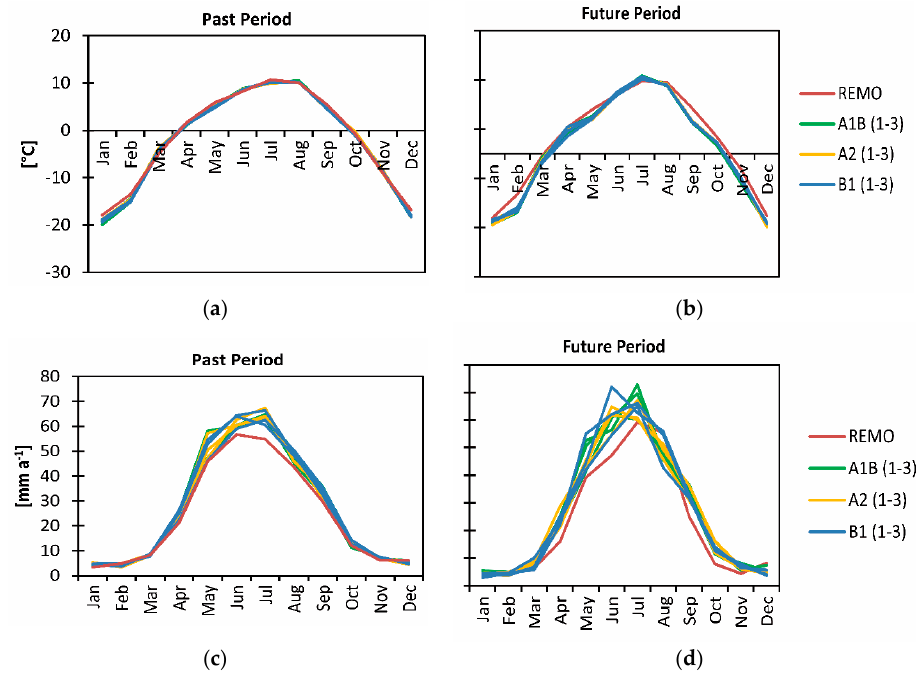
Figure 5. Monthly temperature means ( a , b ) and precipitation sums ( c , d ) of the Past and the Future Period.